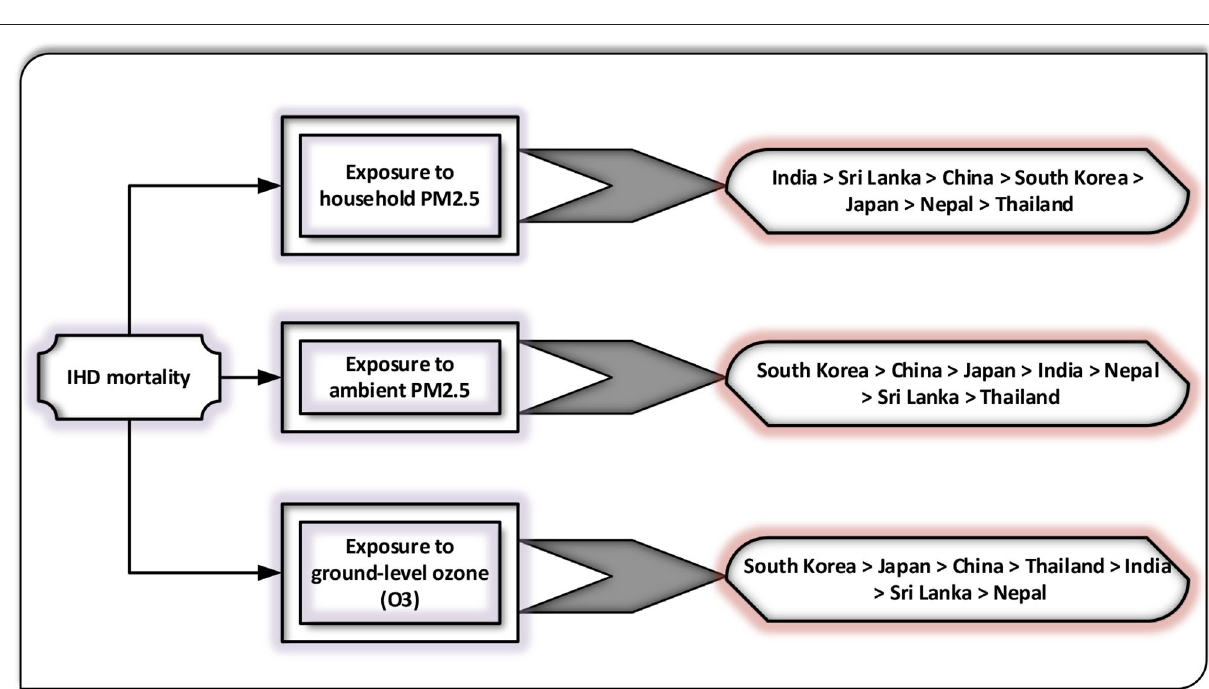
factors. The A-GRA and the SS-GRA models have a scale ranging from [0, 1], while D-GRA has a scale ranging from [0.5, 1]. If the estimated value is close to 1, it is considered significantly associated and if it diverges from 1, it is considered to be weak. Table 4 shows the notations